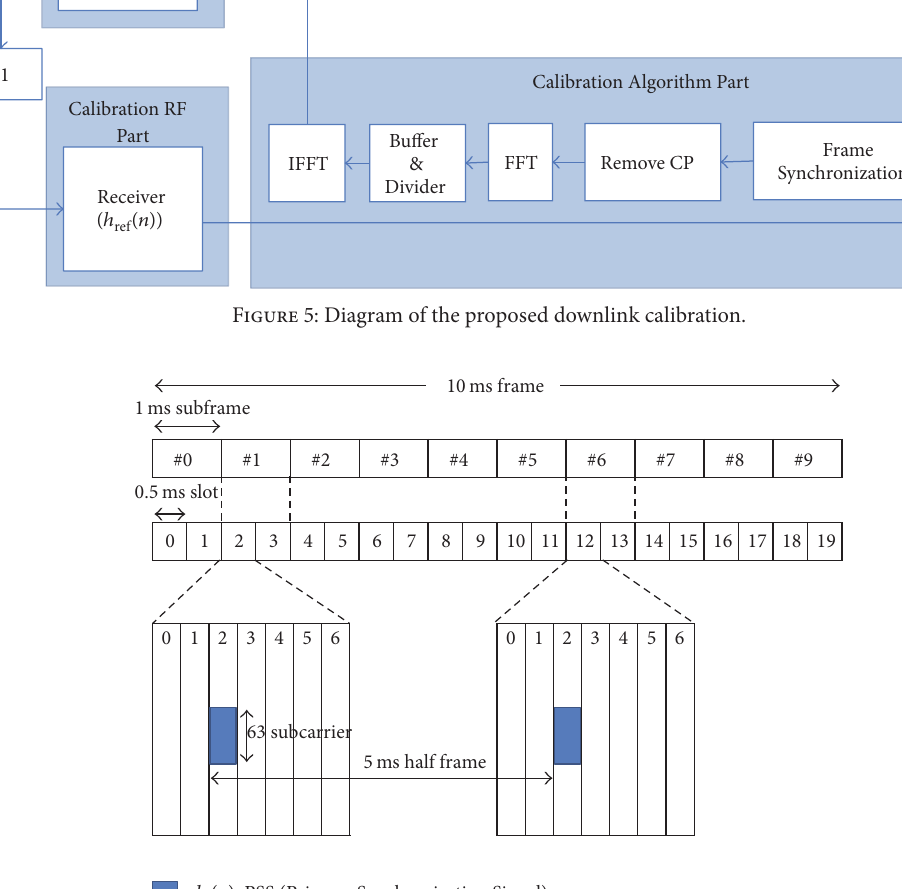
Figure 6: Architecture of downlink LTE